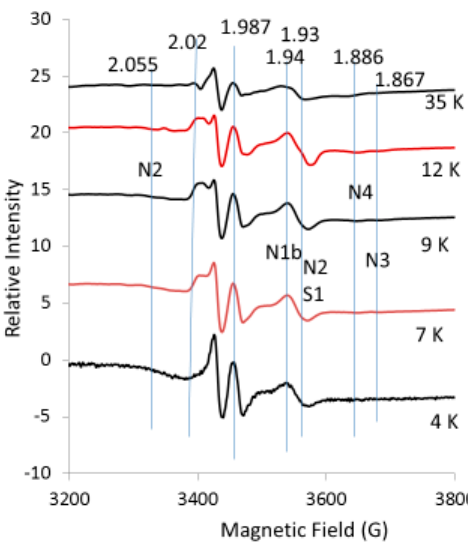
Figure 6. EPR spectra for control liver tissue at 4 K, 7 K, 9 K, 12 K and 35 K. The vertical lines indicate the g-values for EPR lines from Complex I (N2, N1b, N4) and Complex II (S1) discussed in the text. Spectrometer conditions: microwave freq., 9.632 GHz; mod. amp., 5 G; microwave power, 5 mW.